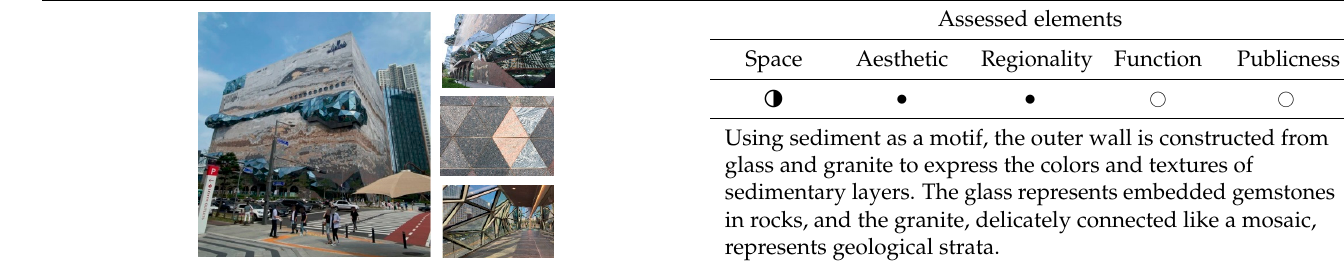
Table 4. Decorative facades: PLACE1 (OMA/GANSAM 2020).